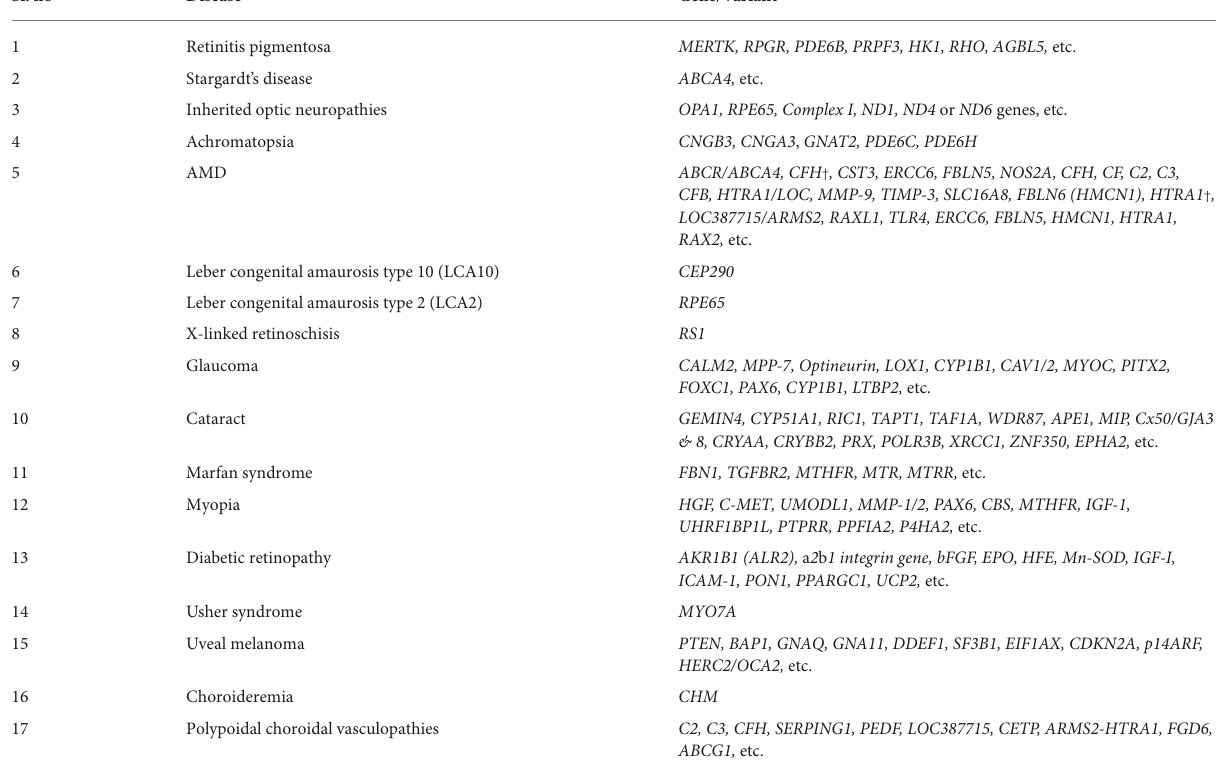
TABLE 2 Genes linked to human eye disorders. Sl.